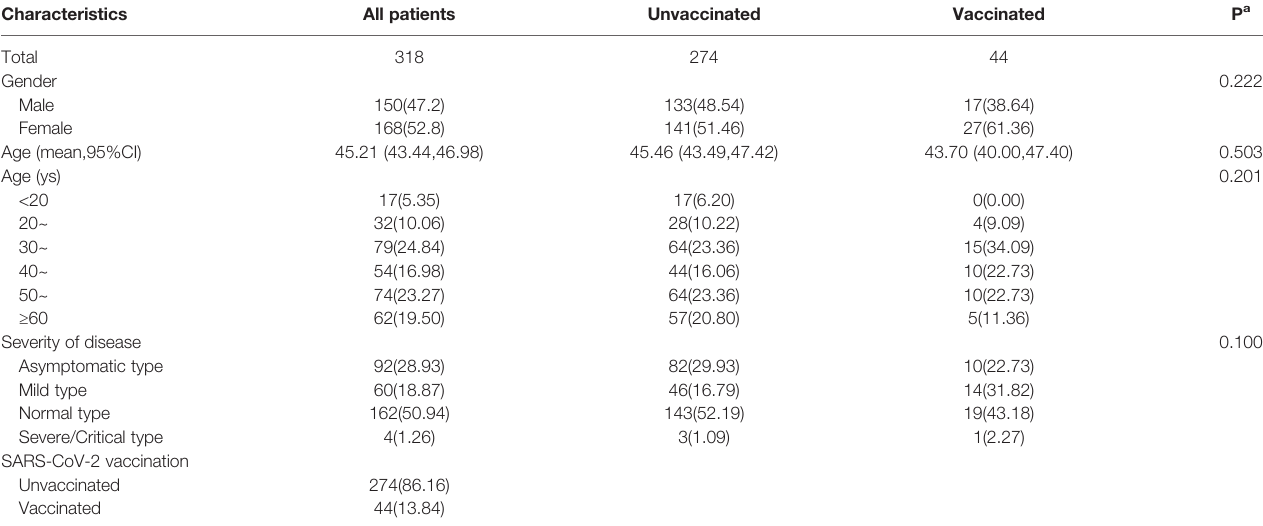
TABLE 1 | Demographic and clinical characteristics of the subjects in this round of